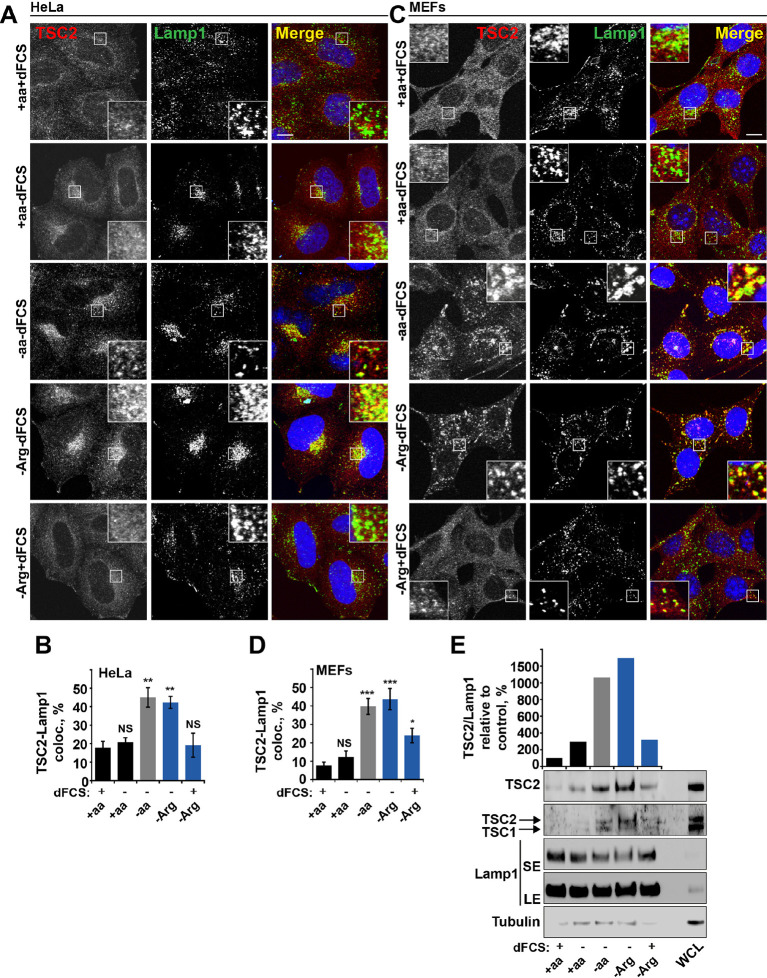
Arginine regulates TSC2 localization to the lysosome.(A–E) Starvation of arginine and growth factors cooperate to promote recruitment of TSC2 to lysosomes. HeLa cells (A, B) and MEFs (C, D) were subjected to different starvation protocols; full nutrient medium (+aa+dFCS), serum starvation (+aa-dFCS), arginine starvation (-Arg+dFCS), or starvation of serum and arginine (-Arg-dFCS). Cells were immunostained with antibodies against TSC2 and Lamp1 (A, C) and percentage co-localization between Lamp1 and TSC2 was determined (B, D). Scale bars: 10 μm. Nuclei are visualized in images with TO-PRO-3 iodide. (E) HeLa cells were subjected to different starvation protocols as indicated for 1 hr prior to harvesting. Lysosomes were isolated and equal amounts of protein in whole cell lysates (WCL) and lysosomal fractions were analyzed by immunoblotting for TSC2, TSC1, Lamp1 and Tubulin. SE: short exposure; LE: long exposure. All graphs represent an average of at least three independent experiments and error bars represent s.e.m. *p<0.05, **p<0.01, ***p<0.005.